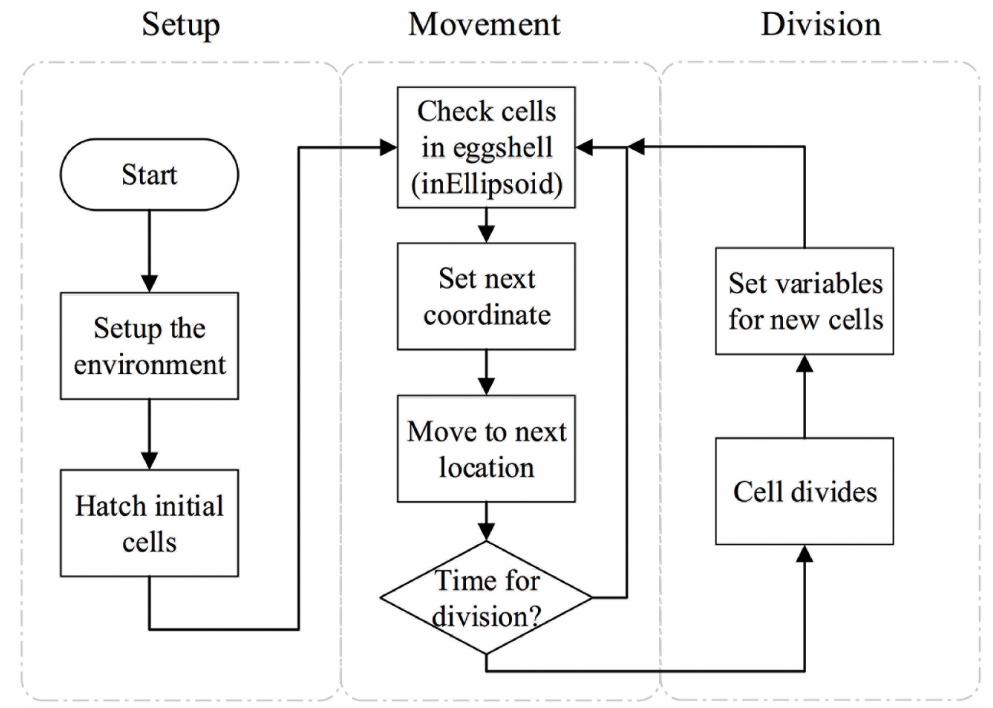
Fig 1. High level representation of framework. Two processes in the the framework, namely “setup” and “execution”. The “execution” process is further dividedinto a “movement” and a